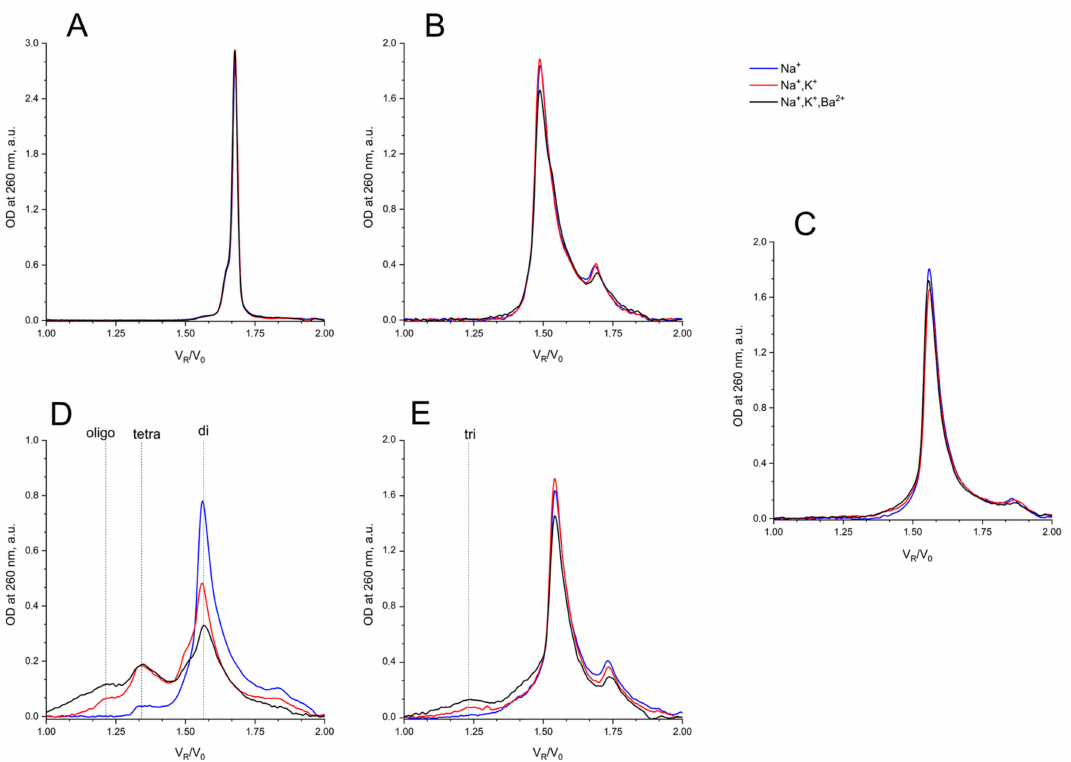
Figure 6. Size exclusion HPLC chromatography analysis of GQs under study: in buffer A (140 mM NaCl; (Na + ), blue), in buffer B (140 mM NaCl, 10 mM KCl; (Na + , K + ), red), in buffer C (140 mM NaCl, 10 mM KCl, 5 mM BaCl 2 ; (Na + , K + , Ba 2+ ), black) at 20 ◦ C: ( A ) HD1, ( B ) bi-HD1, ( C ) AS1411, ( D ) AID-1-T, ( E )